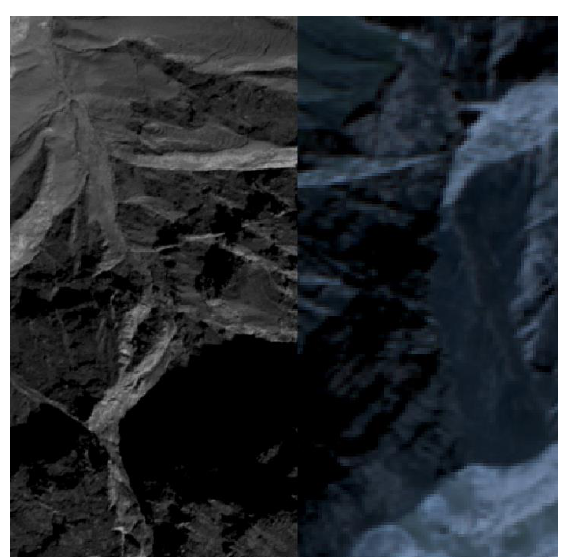
Figure 4. Full-color image and multispectral image overlay (2)